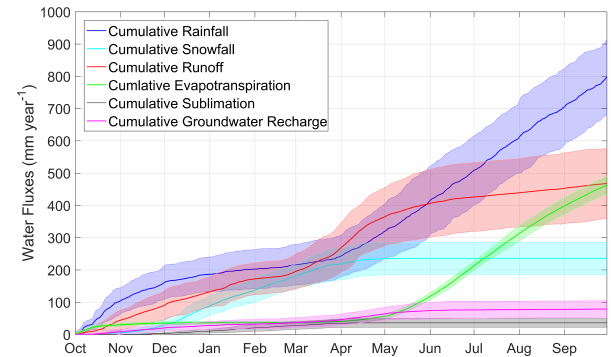
Figure 7. Average annual cumulative water fluxes at the catchment scale between the years 1996 and 2019. The shades around the average values represent the inter-annual variability ( ± standard deviation).